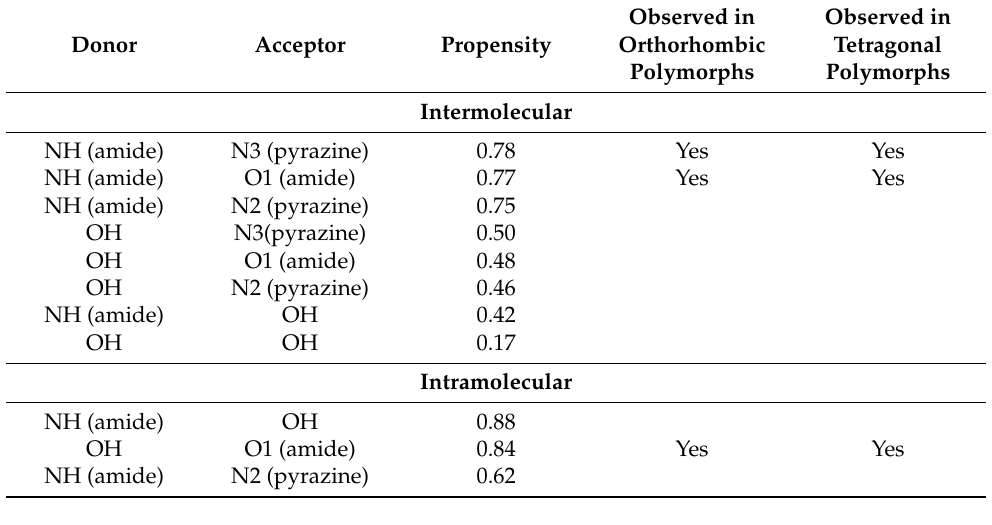
Table 2. Propensities of H-bonding in two polymorphs of favipiravir.